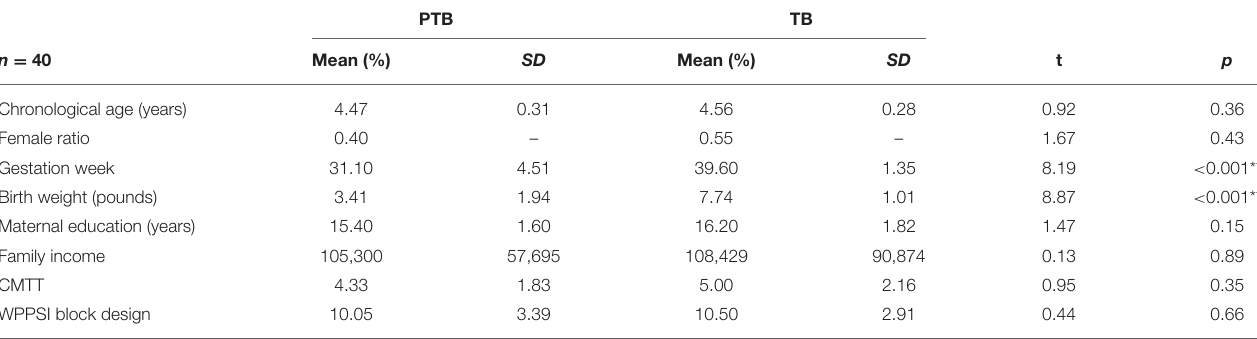
TABLE 1 | Descriptive statistics for demographic characteristics and spatial performance by prematurity group (PTB, TB).